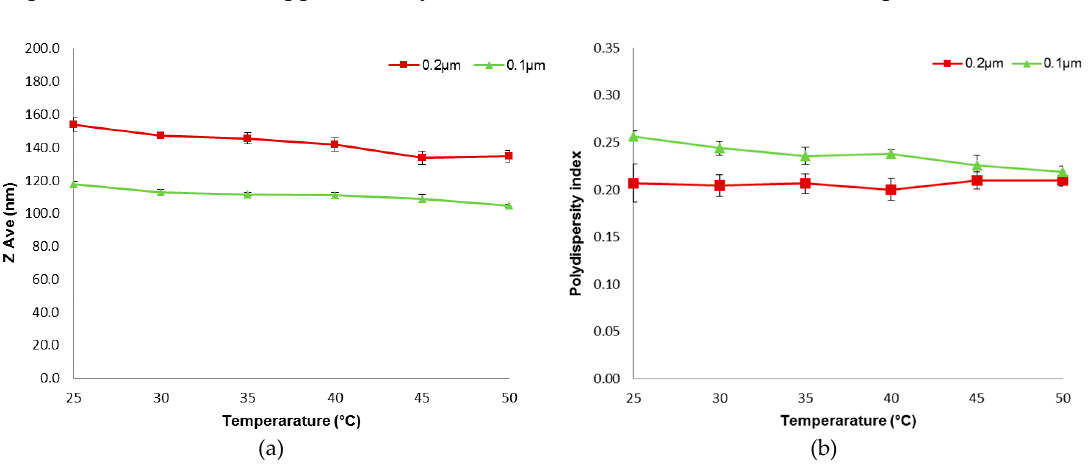
Table 1. Particle size of liposomes after treatment with various size reduction methods (Mean ± SEM, n = 6).